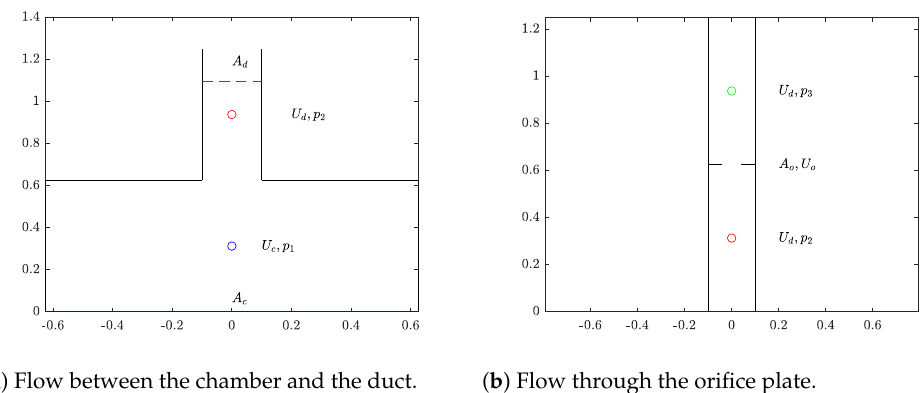
Figure 9. Control volumes for estimating the pressure drop associated with flow from the chamber to the duct and through the orifice